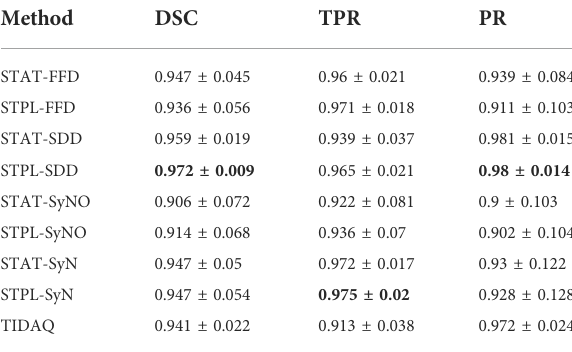
TABLE 3 4% Trabecular Bone Segmentation Performance (mean ± standard deviation). DSC: Dice Similarity Coef fi cient, TPR: True Positive Rate, PR: Precision.